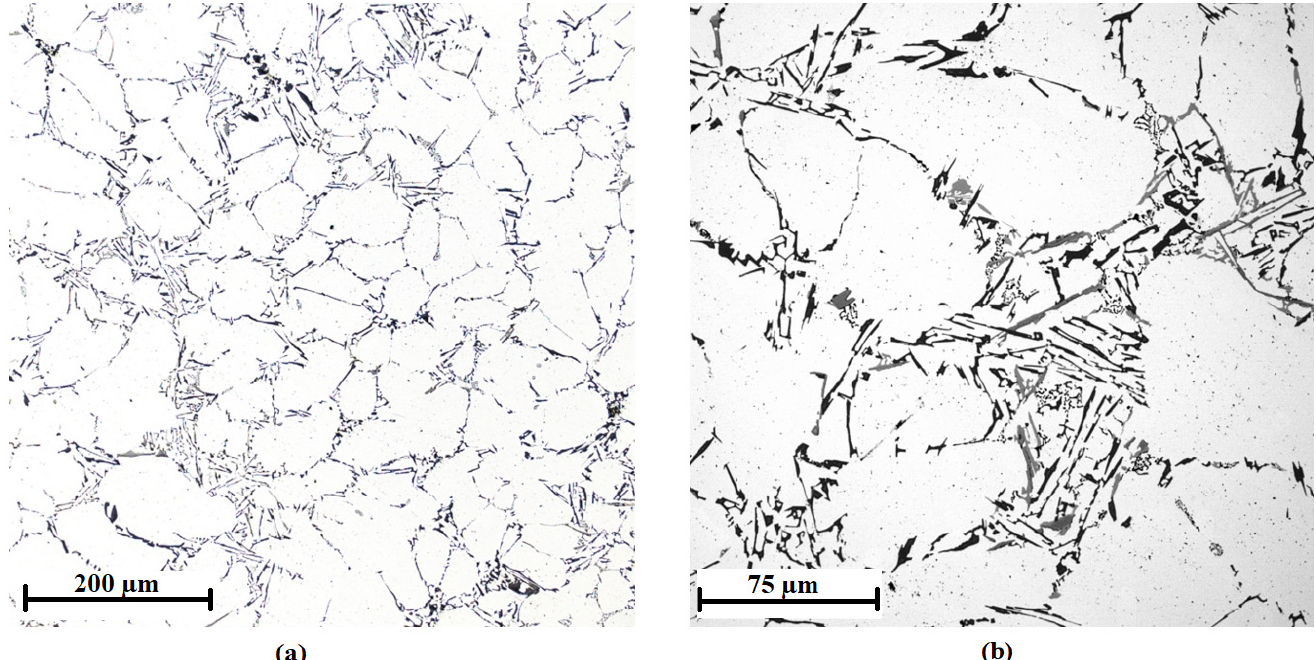
Figure 14. Microstructure of the AlSi7Mg0.3 alloy with the addition of 0.2 wt % AlTi5B1: ( a ) low- magnification overview, ( b ) detail.